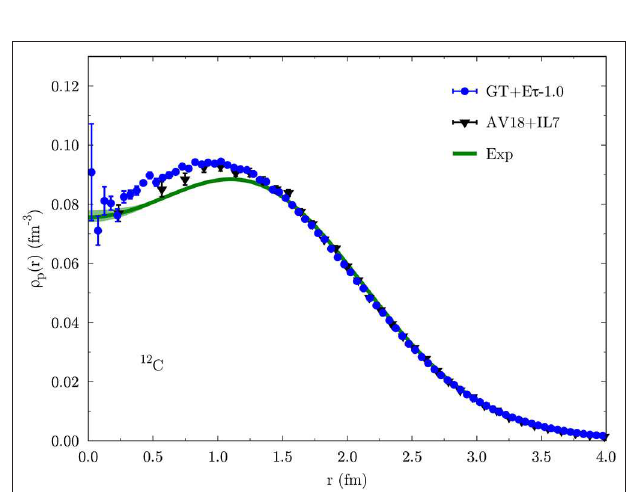
FIGURE 4 | Same as Figure 2 but for charge radii. Experimental data are from references [123–126].